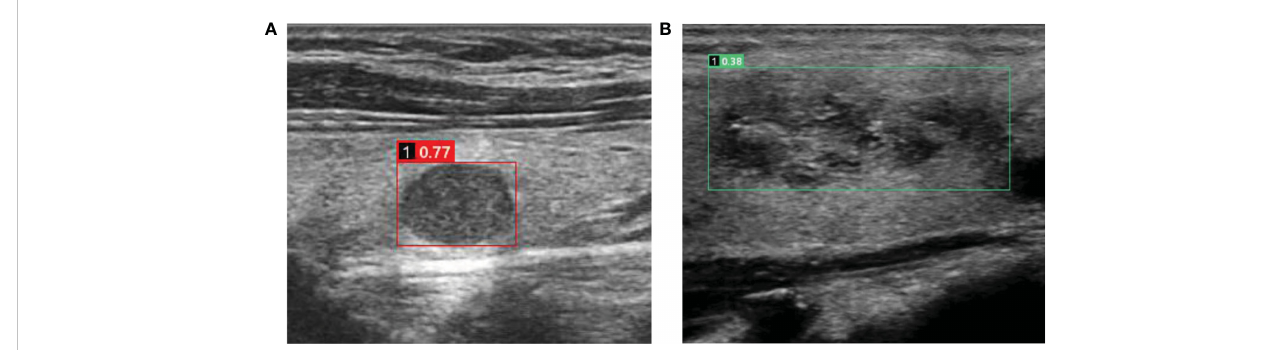
FIGURE 3 Cases in which misdiagnosis was avoided using the AI-SONIC ™ system (A) Image of a 51-year-old man with a right thyroid nodule. The ultrasound image showed a solid hypoechoic nodule with a clear boundary and regular morphology. No obvious malignant features were observed. However, the nodule earned a score of 0.77 according to the AI-SONIC ™ system, indicating a high risk of malignancy. Postoperative pathological examination con fi rmed the diagnosis of medullary thyroid carcinoma. (B) Image in a 56-year-old woman with a right thyroid nodule. The ultrasound image showed a solid isoechoic nodule with obscure boundary and irregular morphology, and the aspect ratio was <1. The internal echo was not uniform, and microcalci fi cation could be seen. Multiple guidelines indicated a high risk of malignancy. However, the nodule earned a score of 0.38 according to the AI-SONIC ™ system, indicating a high probability of a benign nodule. Postoperative pathological examination con fi rmed the diagnosis of nodular goiter, and interstitial fi brosis and focal cholesterol crystal could be